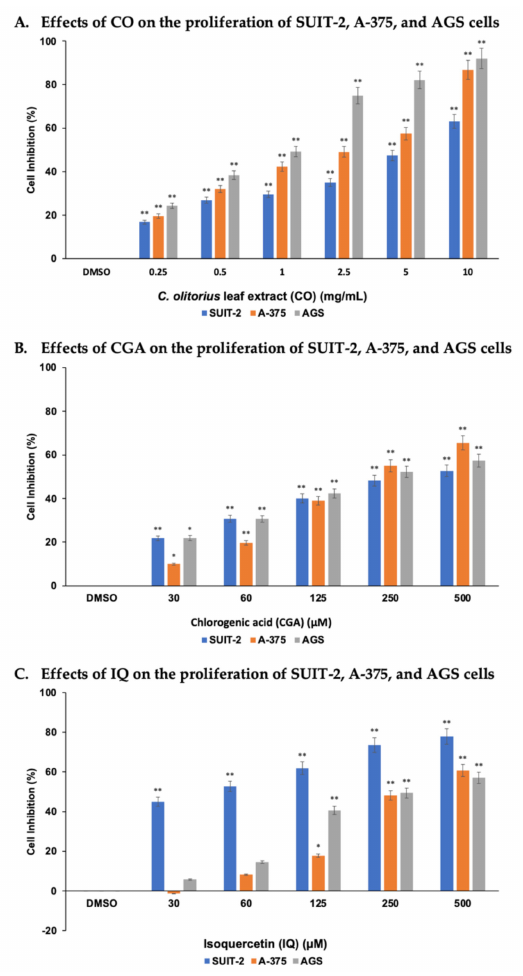
Figure 2. CO, CGA, and IQ induced antiproliferative activities in human cancer cells in the MTT assay ( A – C ) after 48 h. Data are represented as mean ± SEM ( n = 3). * p < 0.05 or ** p < 0.01 as compared to 0.5% DMSO treatment (control group). Table 1. Median inhibitory concentration (IC 50 ) values of Corchorus olitorius aqueous extract, chloro- genic acid, and isoquercetin for SUIT-2, A-375, and AGS cancer cell